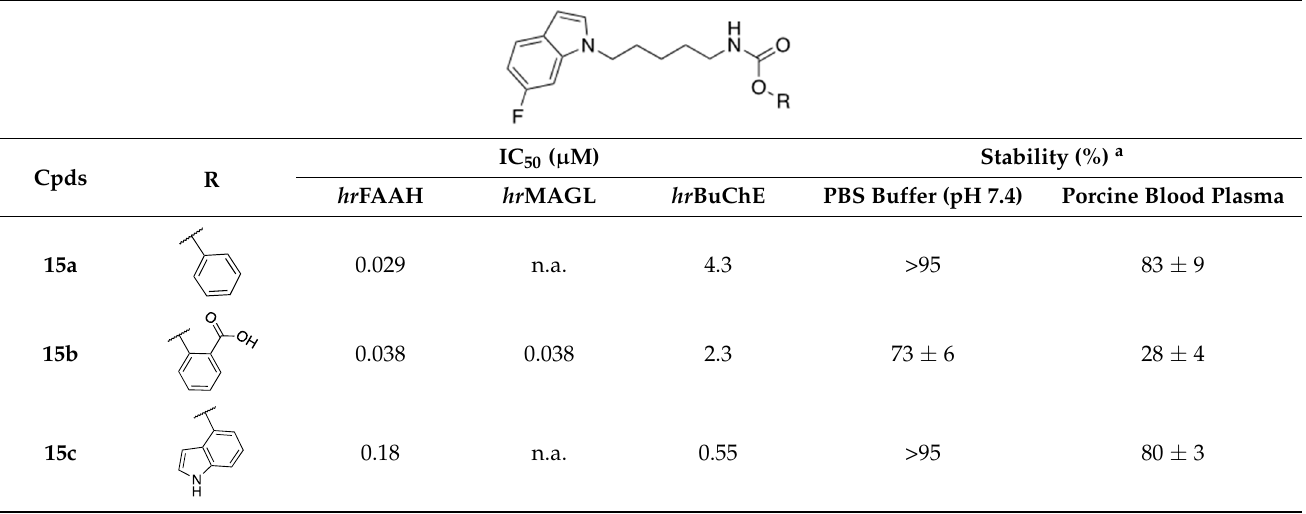
Table 9. Inhibitory activities against human recombinant FAAH, MAGL, and ChEs and chemical and metabolic stability in aqueous PBS Buffer and porcine blood plasma.